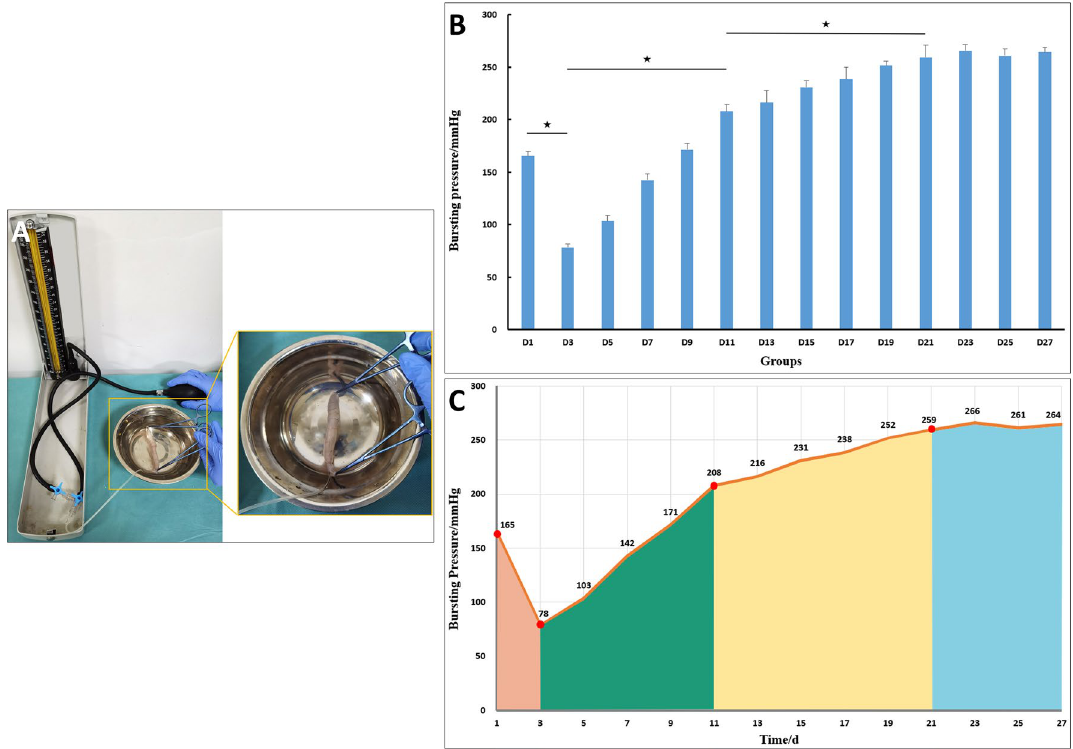
Figure 3. Burst pressure. ( A ) Schematic diagram of burst pressure measurement. ( B ) Bar graph of the mean burst pressure for each group. (“ ★ ” shows P < 0.001) ( C ) Line graph of the mean burst pressure for each